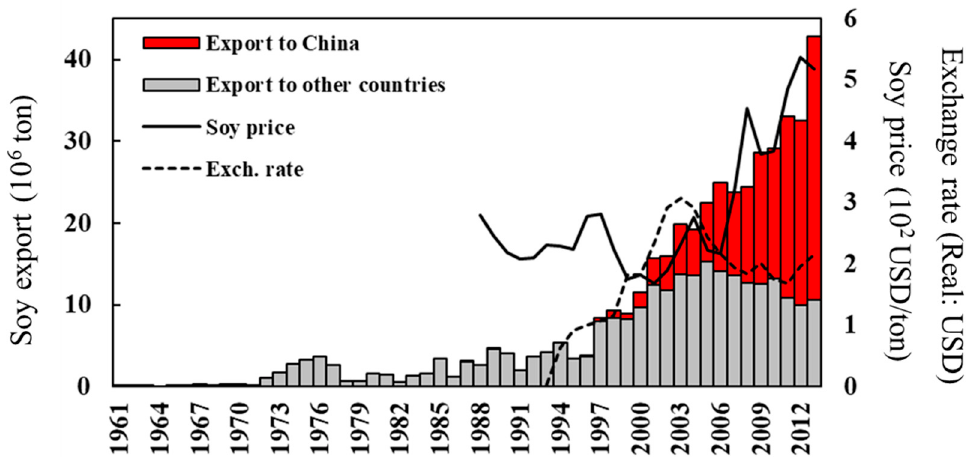
Figure 3. Historical variability of Brazilian soy exports (left axis), and share of China in relation to world export (left axis) [25]. On the right axis, the international market soy price [26] is shown in continuous black line and the exchange rate Brazilian Real/US Dollar is shown in dashed line [27].